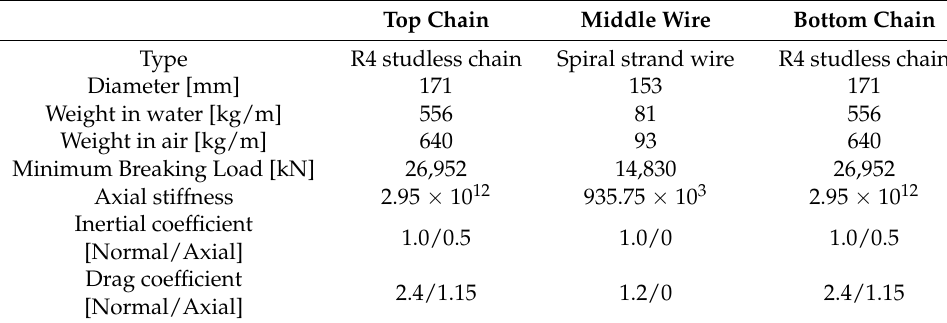
Figure 4. The side view of the target mooring system. Table 3. Properties of each segment.